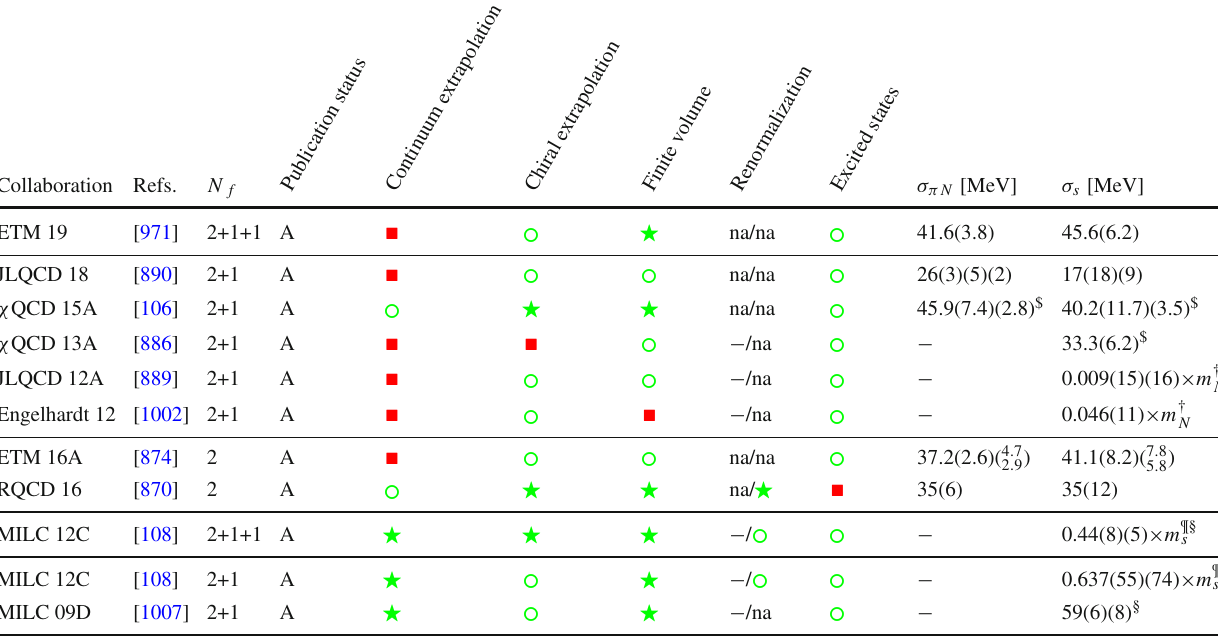
Table 73 Overview of results for σ π N and σ s from the direct approach (above) and σ s from the hybrid approach (below)